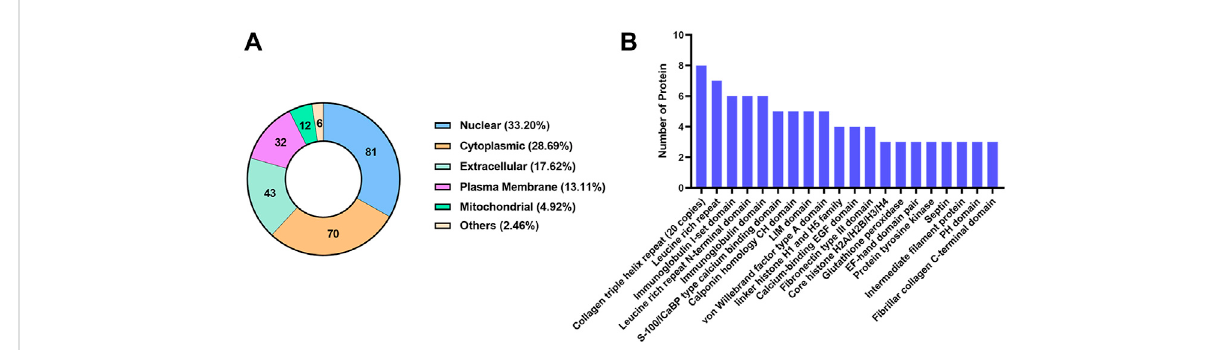
FIGURE 6 Classi fi cationofDEPsbasedonsubcellularlocalizationanddomain. (A) ThenumberanddistributionratioofDEPsineachsubcellularorganelle. (B) The number of proteins in the domains (top 20).